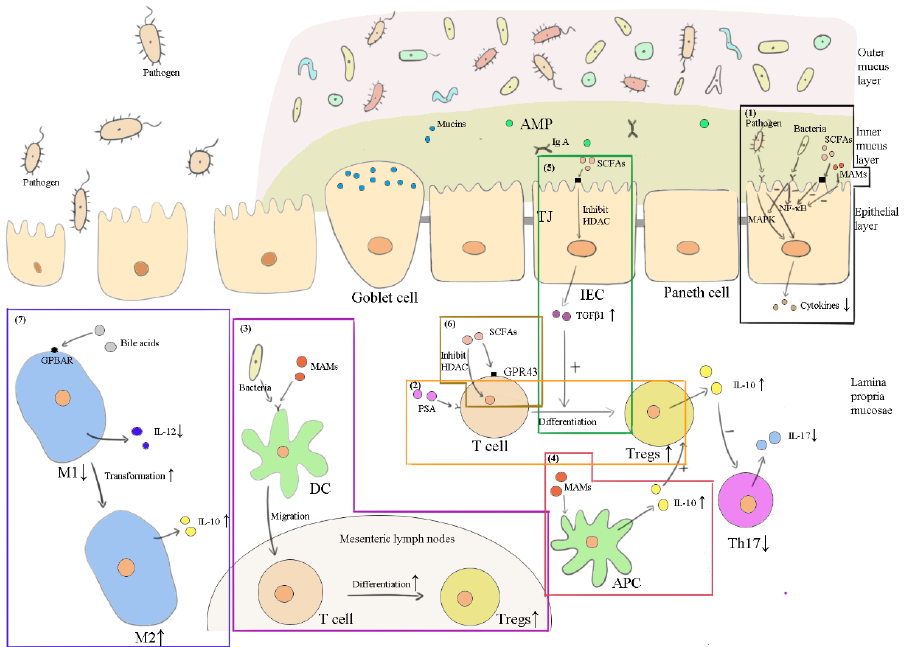
Figure 3. How the important components in FMT exert anti-inflammatory actions. “+” represents promotional effects, while “-” represents suppressive effects. (1) Commensal bacteria inhibit the nuclear factor- κ B (NF- κ B) and the mitogen-activated protein kinase (MAPK) signaling pathway to decrease in- flammatory cytokines. SCFAs (from donor feces or bacteria) and microbial anti-inflammatory molecules (MAMs from bacteria) inhibit NF- κ B. (2) Polysaccharide A (PSA) from bacteria binds to the toll-like receptor (TLR) 2 of T cells, inducing regulatory T cell (Treg) production. (3) MAMs and bacteria stim- ulate dendritic cells (DCs) to migrate to the mesenteric lymph nodes, thus inducing Treg production. (4) MAMs also stimulate antigen-presenting cells (APCs) to produce IL-10. (5) SCFAs promote IECs to secrete the transforming growth factor (TGF) β 1, which boosts the differentiation of T cells into Tregs. (6) SCFAs can directly induce Treg production through GPR43 on T cells or by inhibiting histone deacety- lase (HDAC) in T cells. (7) Bile acids promote classically activated (M1) macrophages’ transformation into alternatively activated (M2) macrophages to limit